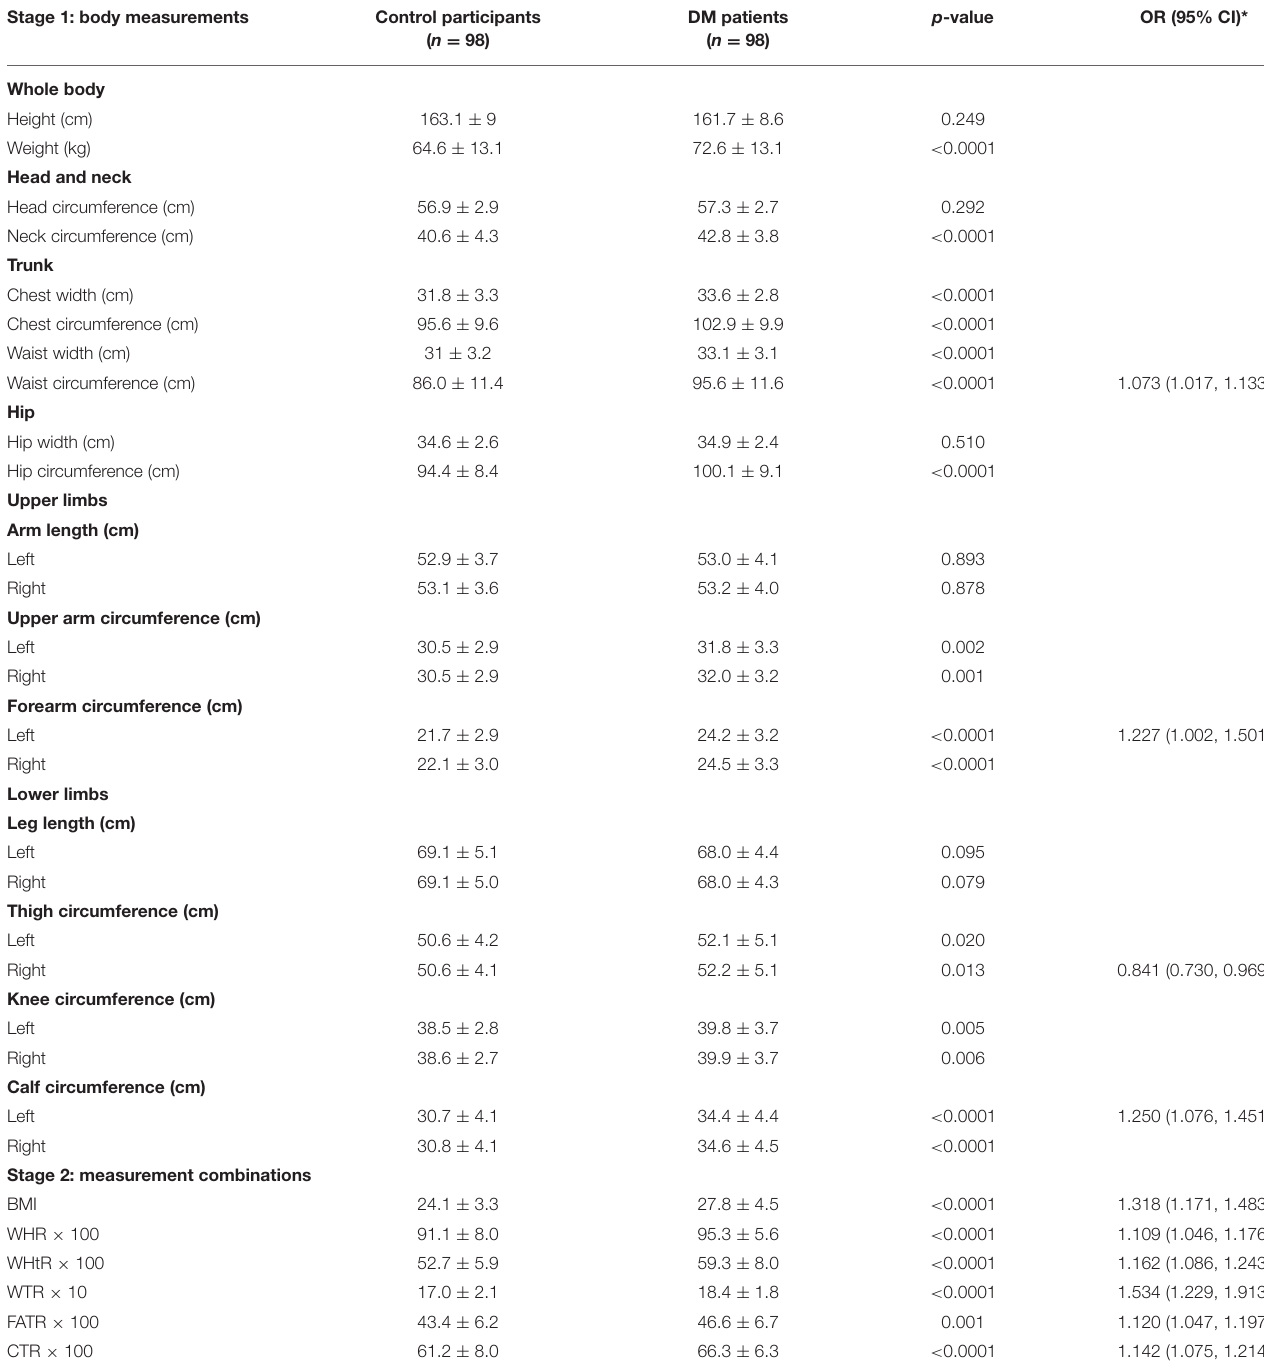
TABLE 2 | Comparison of body measurements between the study